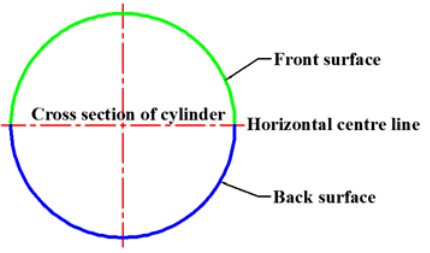
Figure 7. Sketch map of the cylinder surface regions.